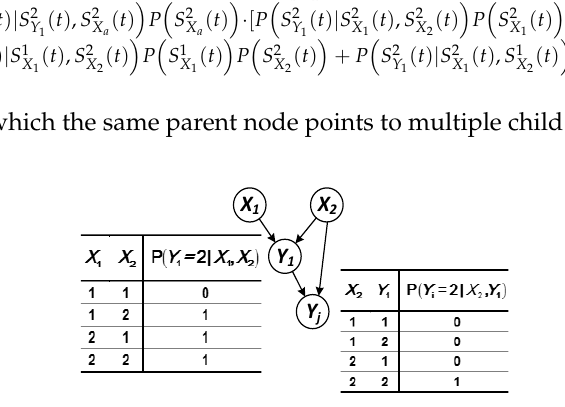
Figure 6. Logical structure in which the same parent node points to multiple subnodes.